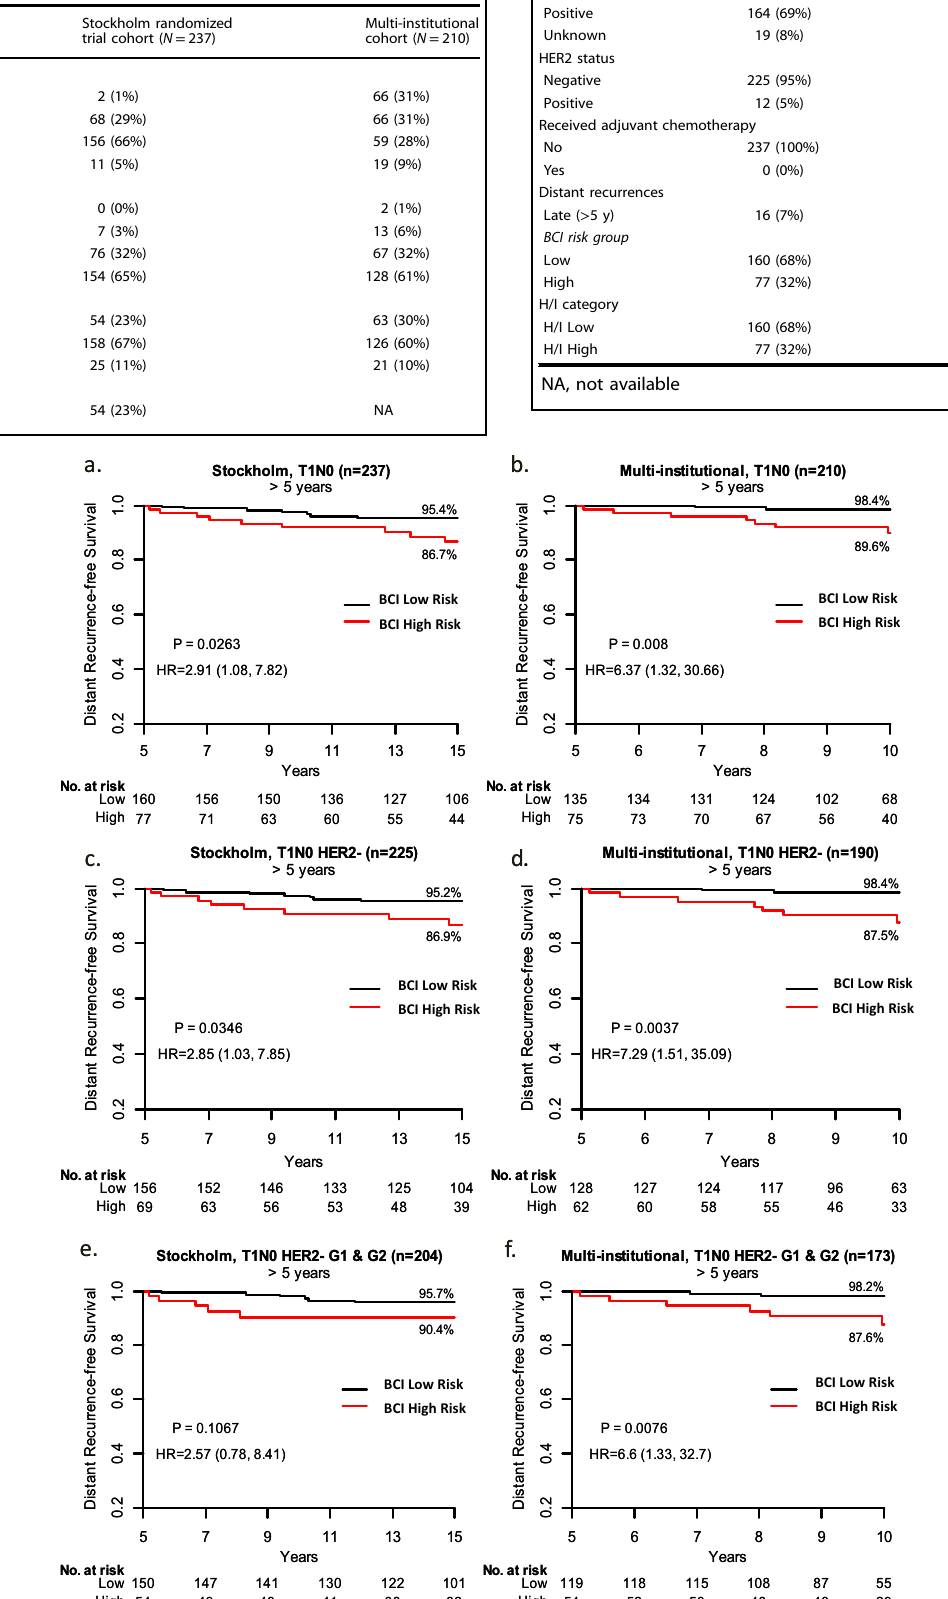
Stockholm randomized trial cohort ( N = 237)